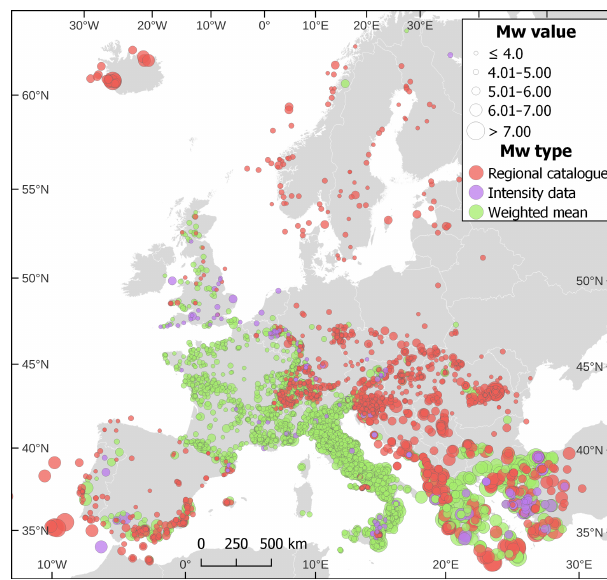
Figure 7. Geographical distribution of earthquakes in EPICA ac- cording to the value (size of the symbols) and type (colour) of the magnitude: reassessed from intensity data, reassessed from a re- gional parametric catalogue, or the weighted mean of the two re- assessments.